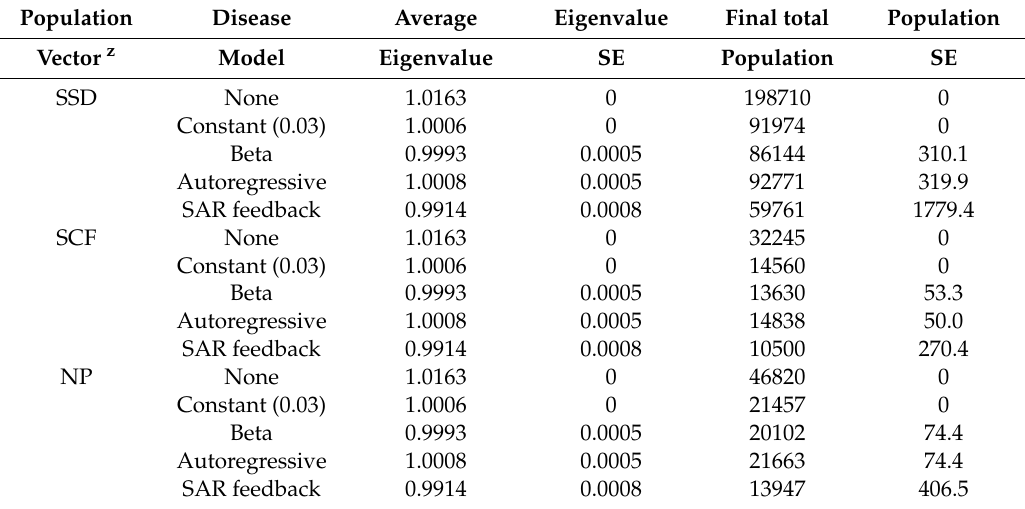
Table 5. Summary statistics for 100 runs of a demographic matrix projection model for three Pinus radiata starting population vectors projected over 50 decades in the presence of various representations of pitch canker